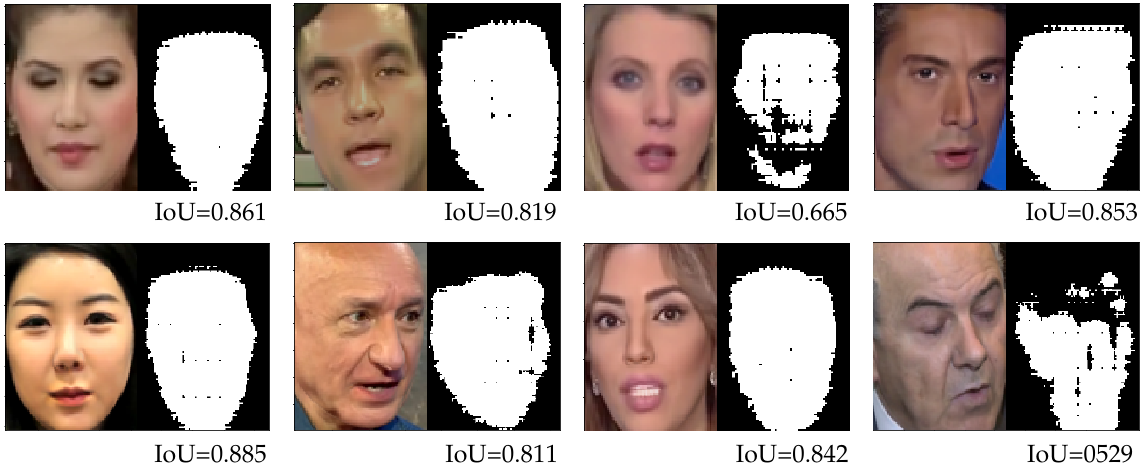
Figure 8. Randomly selected images from the result of detecting the fake images by the model trained with the Face2Face dataset. The left side of every pair of sub-images is a fake image and the right side of every pair of sub-images is the prediction result.